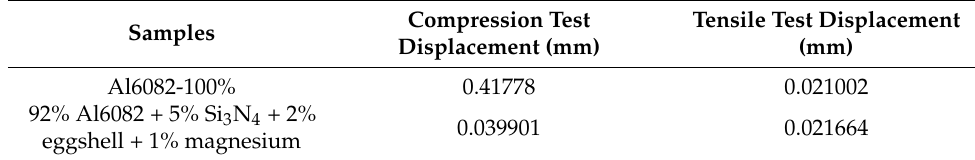
Table 17. Nodal displacements of Al6082 and Al composite during compression and tensile.